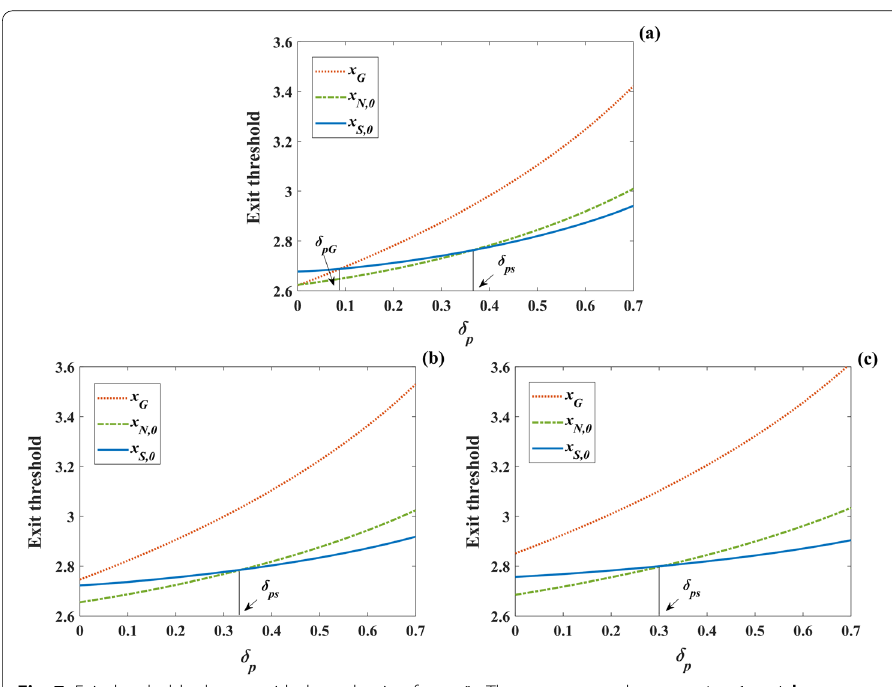
Fig. 7 Exit thresholds change with the reduction factor δ p . The parameter values are a L + 1 = 4 ; b L + 1 = 5 ; c L + 1 =